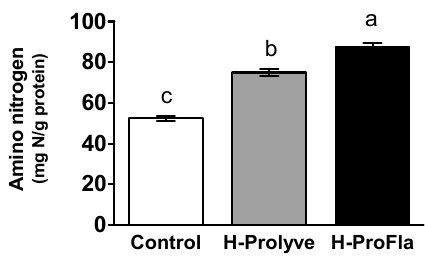
Figure 1. Amino nitrogen liberated from conchocelis after 2 h hydrolysis at 50 ◦ C with Prolyve (H- Prolyve) and 4 h hydrolysis with Prolyve plus Flavourzyme (H-ProFla). Values represent mean ± SD ( n = 3). Results expressed as mg of amino nitrogen per g of protein (mg N/g protein). Different letters denote significant differences at p < 0.05 for each